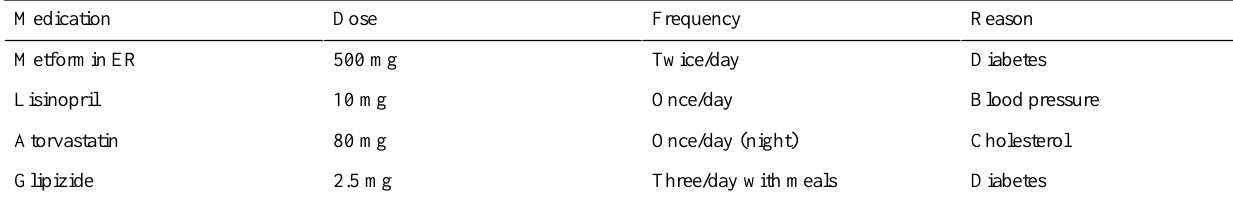
Table 4. Scenario patient medication